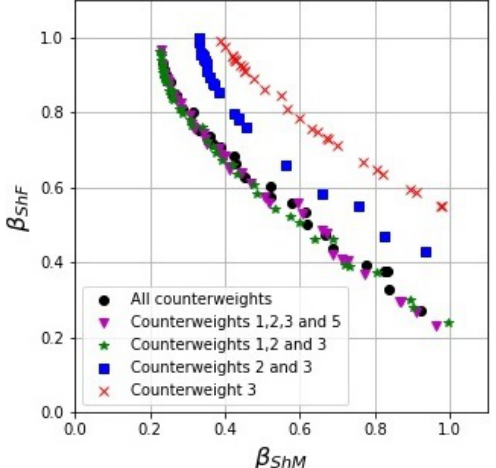
Figure 9. Pareto front comparison of the optimization objectives β ShM and β ShF according to the number of